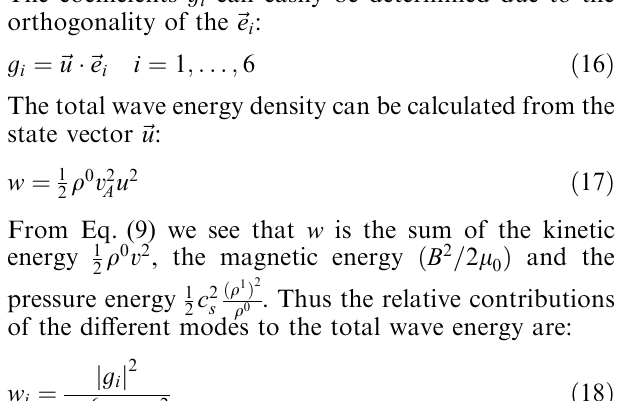
Fig. 3. The eigenvectors of Hall-MHD. Plasma background parameters: h (cid:136) 20 (cid:14) , b (cid:136) 0 : 01, v 0 (cid:136) 0. Shown are the fast mode ( solid line ), x Alfve´ n mode ( dotted line ) and slow mode ( dashed